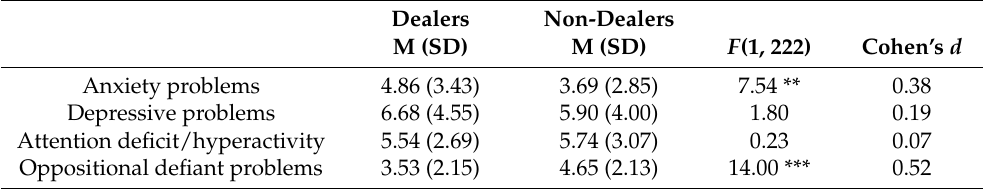
Table 4. Mental Health Problems Among Non-Dealers ( N = 79) and Dealers ( N = 147).